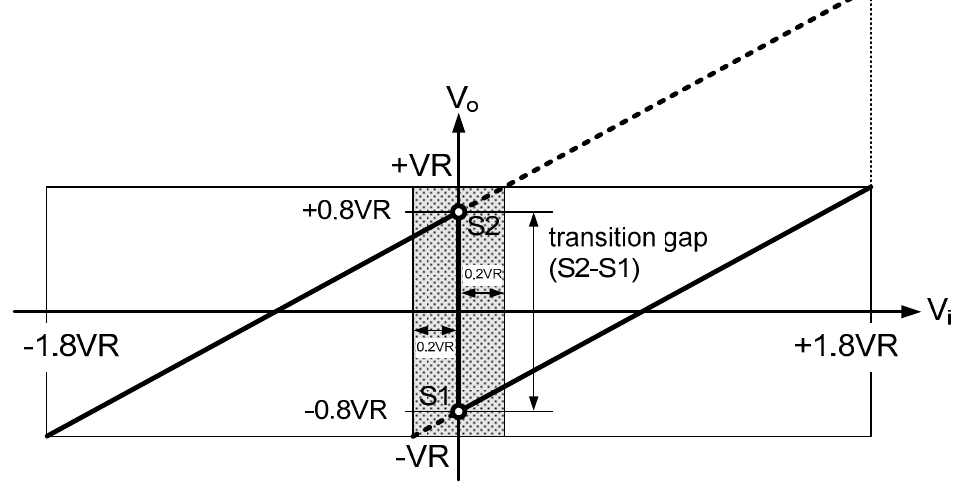
Figure 2. Transfer curve of the proposed 1-bit FADAC.